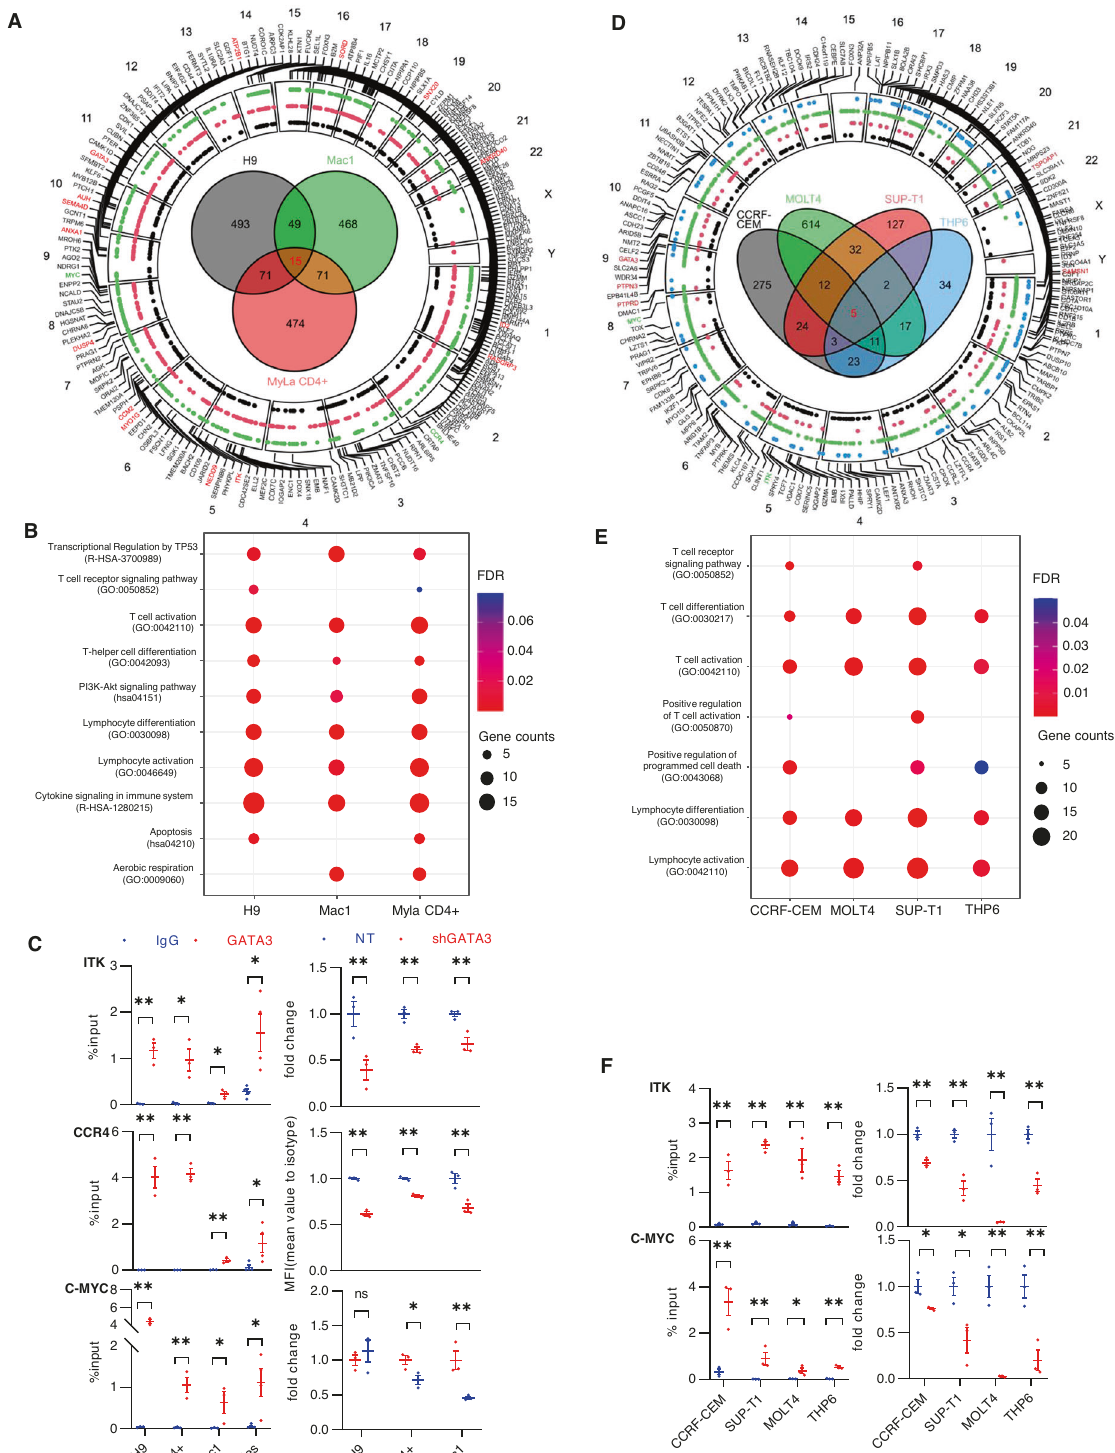
anthracycline-based regimen) and those receiving palliative therapies (most commonly hospice care, summarized in Supple- mental Table 1) was not observed, highlighting the need for improved therapeutic strategies in patients with GATA-3 PTCL. Suf fi cient tissue was available for a subset of these patients,